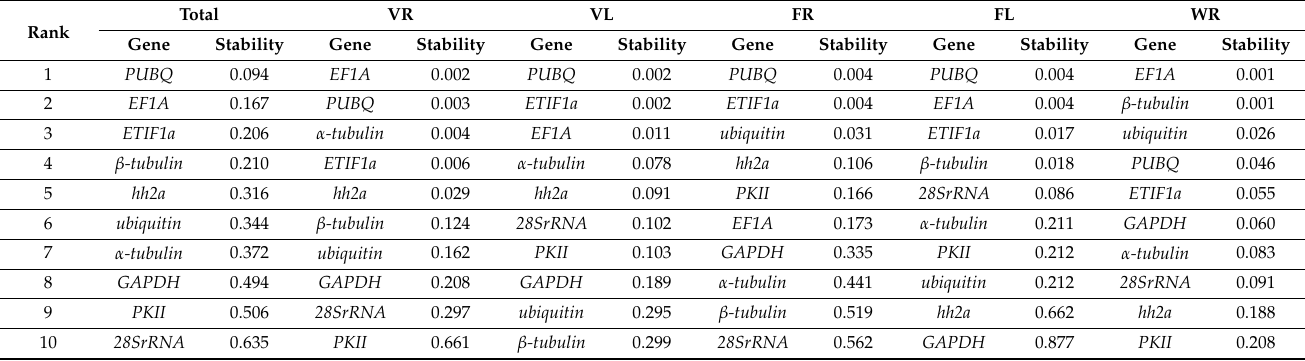
Table 2. Expression stability of the candidate reference genes calculated by the NormFinder software.